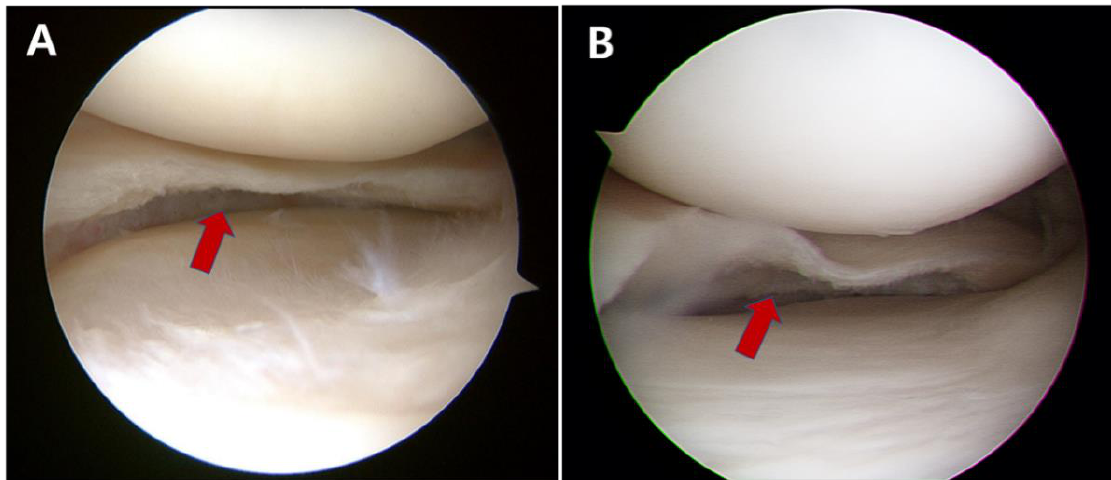
Figure 2. Resection of unstable inferior leaf for horizontal cleavage tear of medial meniscus was performed. ( A ) Complete resection: the inferior leaf of the horizontal cleavage tear was completely excised (red arrow), and the meniscal tissue of the inferior leaf at the torn portion was not left up to the joint capsule. ( B ) Partial resection: the meniscal tissue of the inferior leaf was partially resected, and the stable peripheral area of torn meniscus remained (red arrow).